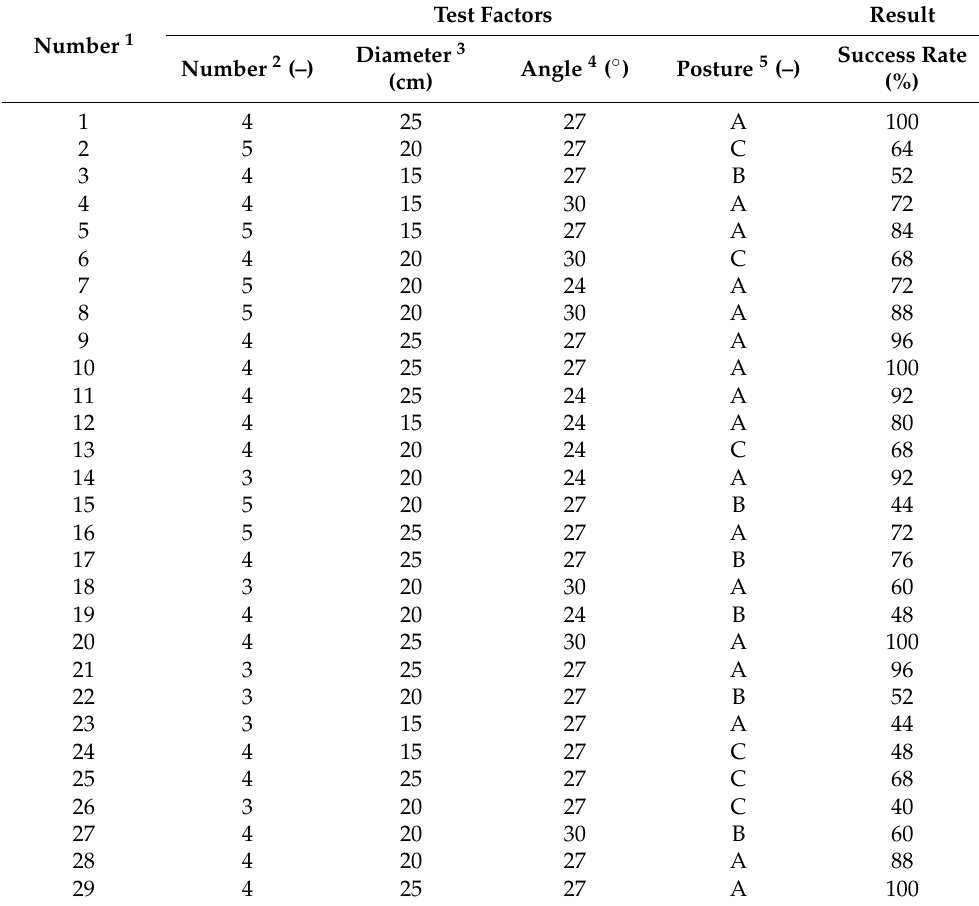
Table 4. Results of orthogonal test for picking mechanical hand-picking